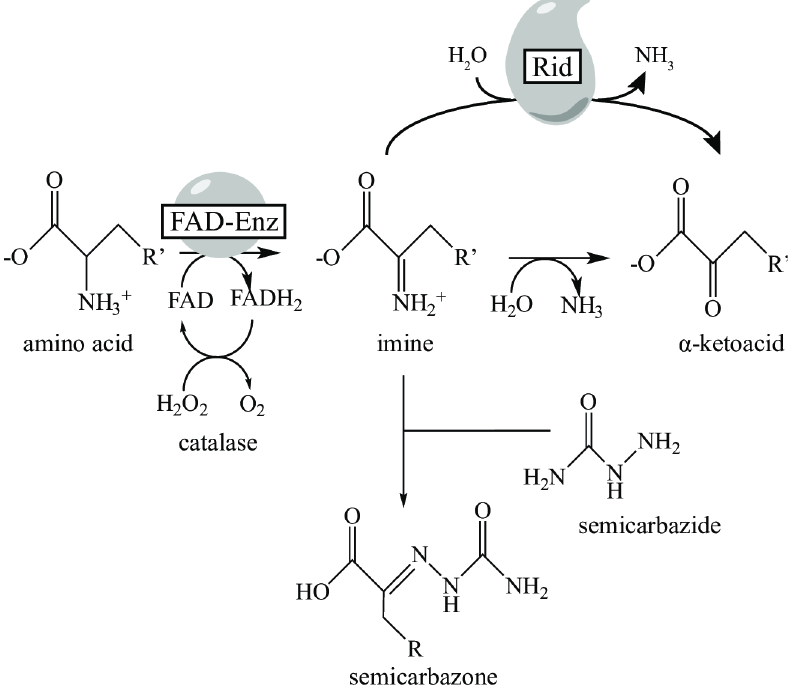
Fig 5. Reaction schemes for FAD-dependent oxidase. The reactionmechanismshows the FAD- dependent productionof an imine from an amino acid. Imines are hydrolyzedby solvent water or facilitatedby Rid proteins, or in the presenceof semicarbazide react to form a semicarbazone compound.R’ representsthe amino acid functionalgroup.